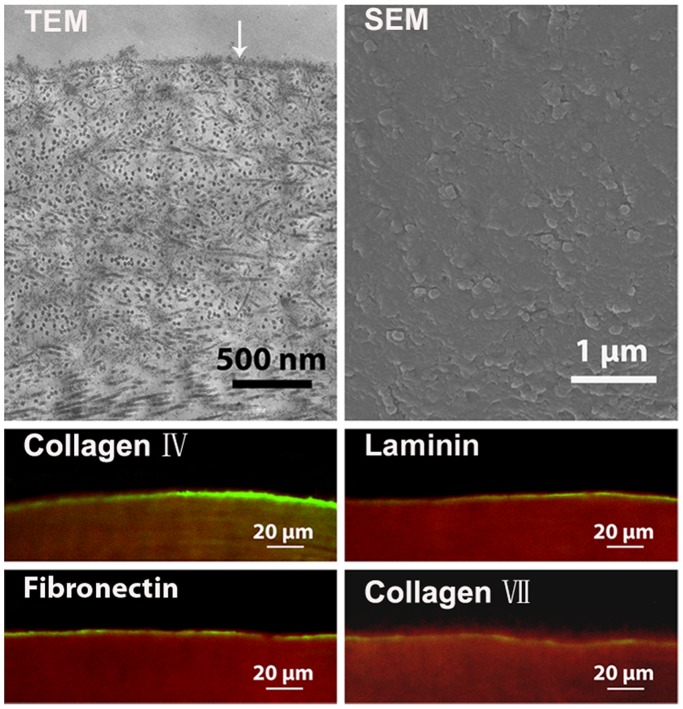
The major components of the basement membrane in APCS (↓: basement membrane components, green: collagen IV, laminin, fibronectin and collagen VII, red: collagen I).